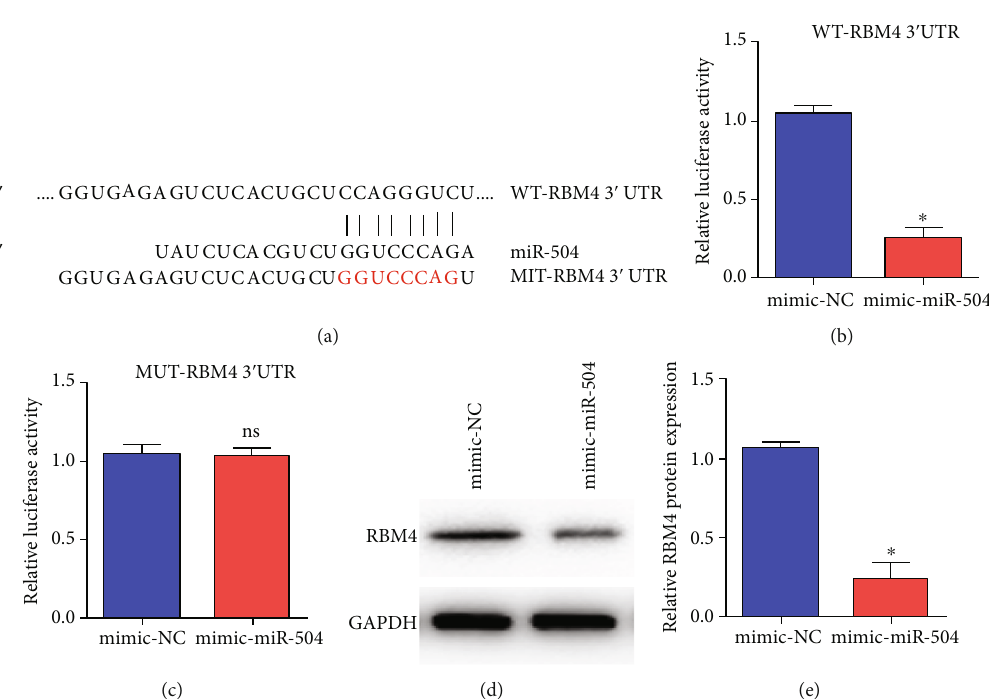
Figure 3: miR-504 directly targeted the RBM4 in gastric cancer cells. (a) Schematic representation of binding sites between miR-504 and RBM4. (b, c) Relative luciferase activity in SGC-7901 cells after transfection with the miR-504 mimic and mimic NC containing the 3 ′ UTR of RBM4 wild type (WT) or mutant type (MUT). (d, e) RBM4 protein expression level in SGC-7901 cells after transfection with the miR-504 mimic or mimic NC. ∗ P < 0 : 05